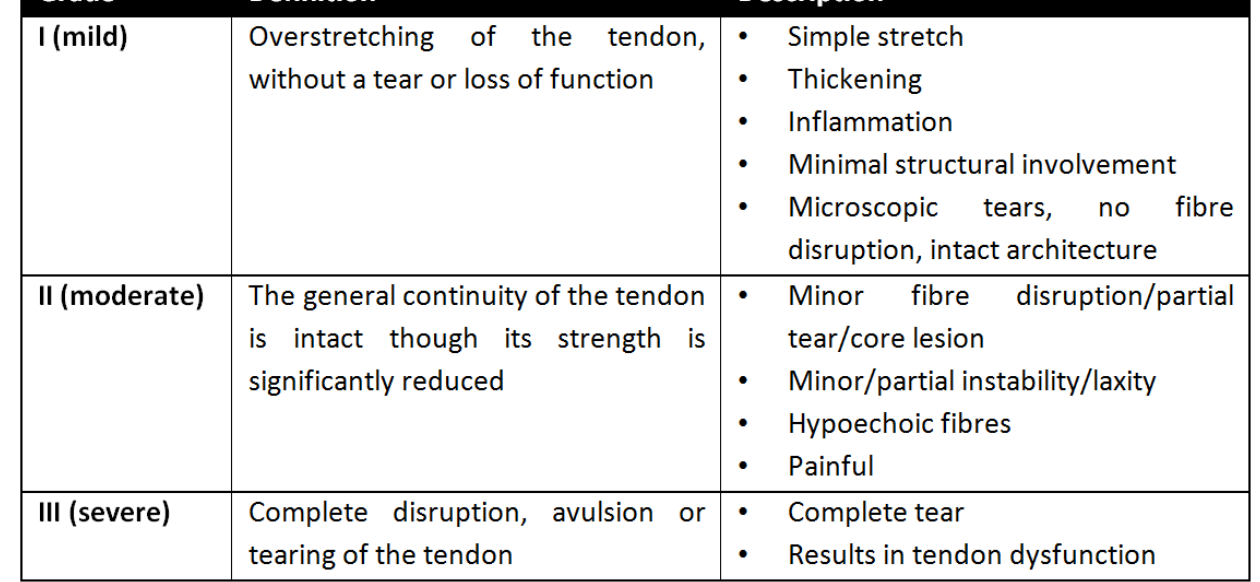
Table 3 : Definition and Description of Numerical 3-Tier Grading Scheme for Tendinous Strain Injury An evaluation generally began with the probe placed longitudinally on the Achilles tendon in caudal/plantar approach. This view allowed for a general approach to the location to assess the anatomy (see figure 7A and 7B). A cross-sectional view was also of importance when evaluating the insertion of the Achilles tendon on the calcaneal tuberosity (see figure 7C and 7D). The Achilles tendon was assessed for disruption of the fibre alignment, fibre tears, complete disruption, avulsion, mineralisation, or evidence of chronic fibrosis or bursitis. Careful evaluation of the region for concurrent tarsal collateral ligaments and retinaculum tear was pursued. The SDFT was dynamically assessed for luxation at the level of the calcaneus, as the hock was flexed. Following along all components of the Achilles tendon, the myotendinous junction (MTJ) and belly muscles were then also evaluated with the transducer placed longitudinally and cross-sectionally. With consideration for the treatment performed, diagnostic ultrasound recheck evaluations were typically recommended at 30, 60 and 90 days to assess healing of the Achilles